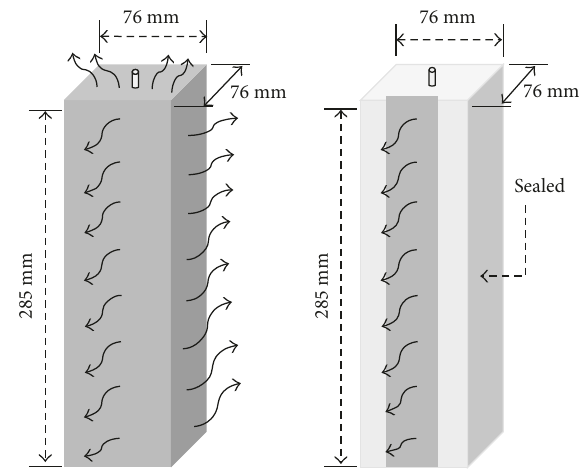
Figure 2: ASTM C157 specimens.